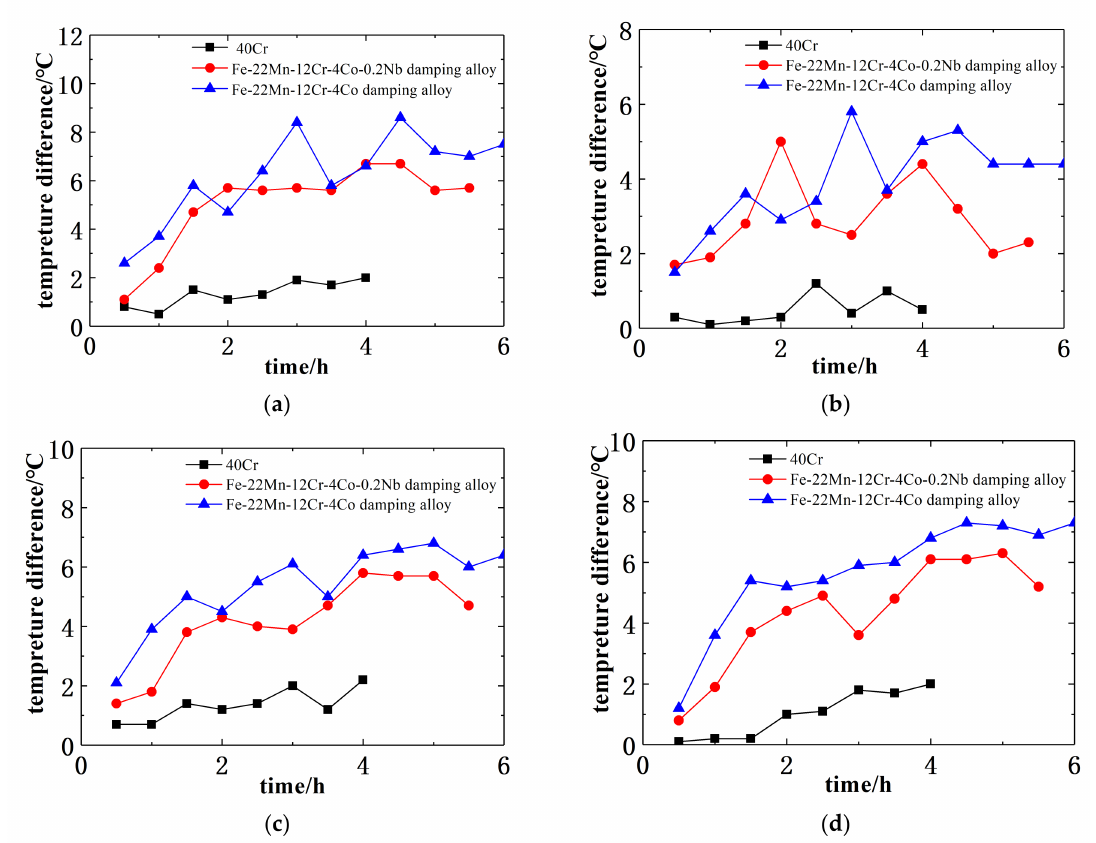
Figure 25. The temperature difference between the different parts of the gearbox and the room temperature: ( a ) difference between input shaft temperature and room temperature; ( b ) difference between end cover temperature and room temperature; ( c ) comparison of difference between output shaft temperature and room temperature; ( d ) comparison of difference between housing temperature and room